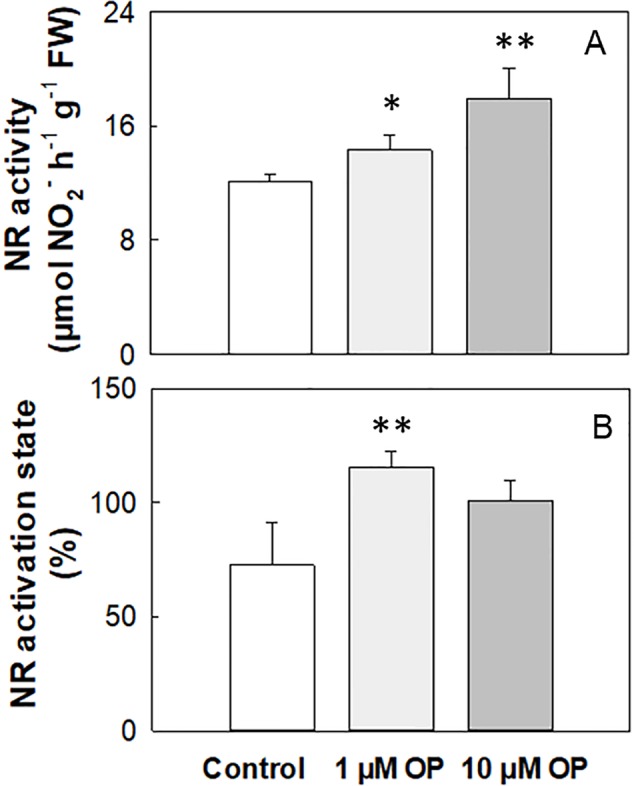
Nitrate reductase activity (A) and activation state (B) of shoots from maize (Zea mays L.) plants hydroponically grown in control (10 mM NO3
-, high N) and stress (1 mM NO3
-, low N) nitrogen conditions with (black bars) and without 1 µM omeprazole (OP) (white bars). Data are means ± SD; n = 3 biological replicates for each treatment. Asterisks denote significant differences (*, P < 0.05; **, P < 0.01) between different OP treated plants.